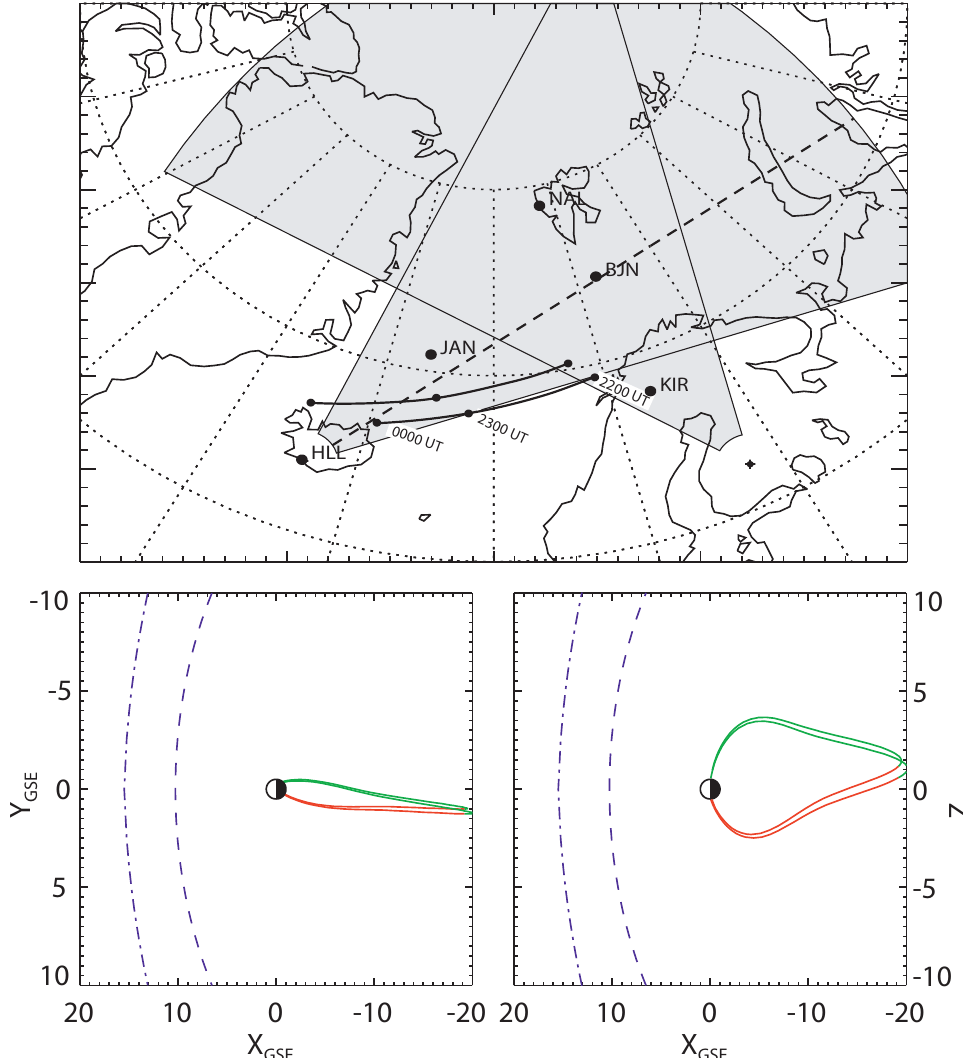
Fig. 1. The fields-of-view of the CUTLASS radar pair shown on a geographic projection from the pole to ∼ 60 ◦ latitude and from − 90 ◦ through to 90 ◦ longitude. Also indicated are the locations of four magnetometers from the IMAGE array (JAN, BJN, NAL, and KIR) and one from the SAMNET array (HLL). The solid black curves represent the footprint of the Cluster (1) spacecraft between 22:00 and 00:00 UT, mapped into the ionosphere using the T-96 magnetic field model with B Z =+ 2 (upper curve) and B Z =− 5 (lower curve). The bottom two panels show the Cluster field lines at 22:00 UT (upper field line in both panels) and 23:00UT in the X − Y and X − Z GSE planes. Indicated by the dashed and dot-dashed curves are a nominal magnetopause and bow shock,